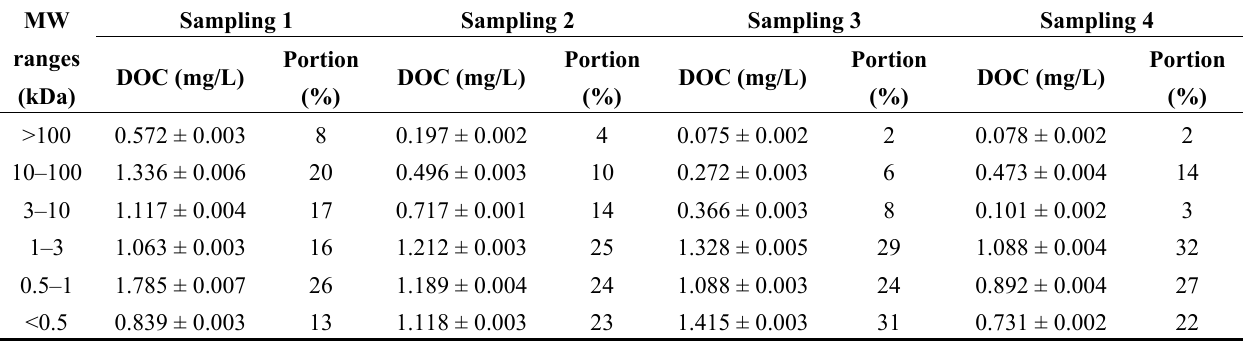
Table 2. The DOC concentration and percentage of different MW fraction groups in different stages of the water treatment process (from Figure 1, Samplings 1–4 represented the water sampling from raw water, after the CTP, ozone and BAC). The standard deviations of replicate measurements for DOC concentrations (n = 3) are shown with the average of the observations, and their RSDs are below